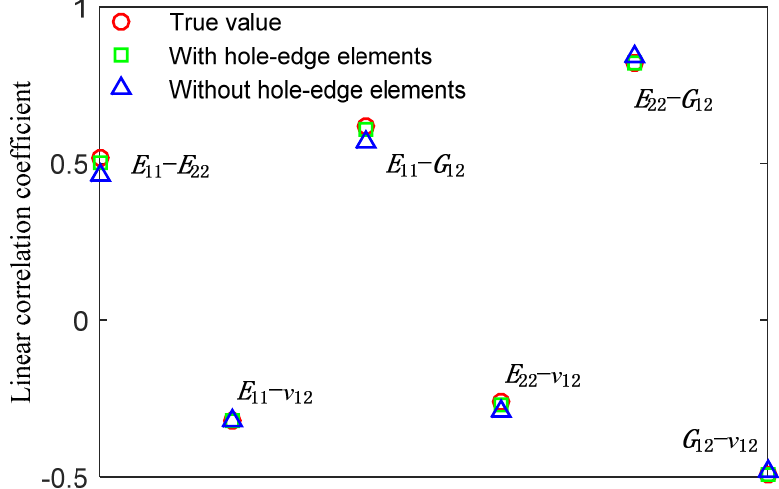
Figure 7. Linear correlation coe ffi cients between carbon fiber reinforced plastic (CFRP) elastic